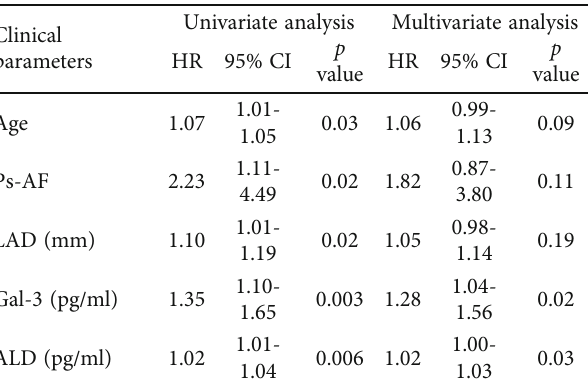
Table 2: Clinical parameters associated with AF recurrence by univariate and multivariate Cox